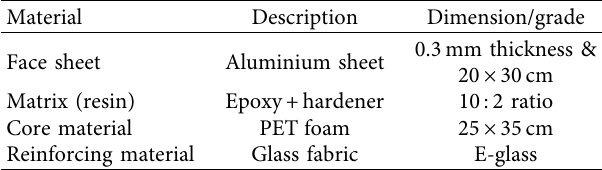
Table 1: Materials required for the fabrication of sandwich panels. Material